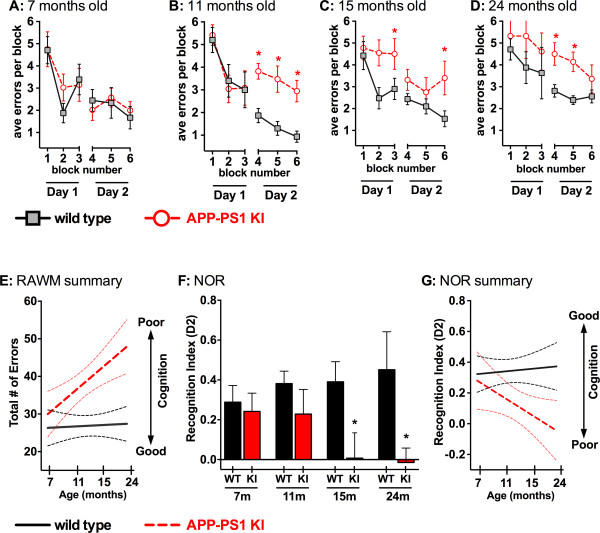
Cognitive behavior of APP/PS1 KI and wild-type control mice. Radial arm water maze (RAWM) performance for each age group: (A) no observable difference is seen between amyloid precursor protein/presenilin-1 knock-in (APP/PS1 KI) mice and wild-type (WT) mice at 7 months of age; however, cognitive deficits are observed in the APP/PS1 KI mice at (B) 11 months, (C) 15 months, and (D) 24 months. (E) RAWM performance as a function of total errors across the four age groups. The WT cognitive performance remained relatively constant across the age groups, while APP/PS1 KI cognitive performance became more impaired as age increased. Data are plotted as mean (solid line) and confidence intervals (dashed lines). (F) Novel object recognition (NOR) performance in APP/PS1 KI and WT mice. The D2 recognition index is used to control for total exploration time: D2 = (novel - familiar)/(novel + familiar). Beginning at 15 months of age, the APP/PS1 KI mice show an inability to discriminate between objects while the WT mice are still able to discriminate. (G) NOR performance as a function of D2 recognition index across the four age groups. The WT cognitive performance remained relatively constant across the age groups, while APP/PS1 KI cognitive performance became more impaired as age increased. N = 5 to 10 mice per group. *P <0.05, for APP/PS1 KI compared with WT. Number of mice: 10 WT and nine KI mice aged 7 months; five WT and 12 KI mice aged 11 months; 10 WT and 10 KI mice aged 15 months; and seven WT and five KI mice aged 24 months.